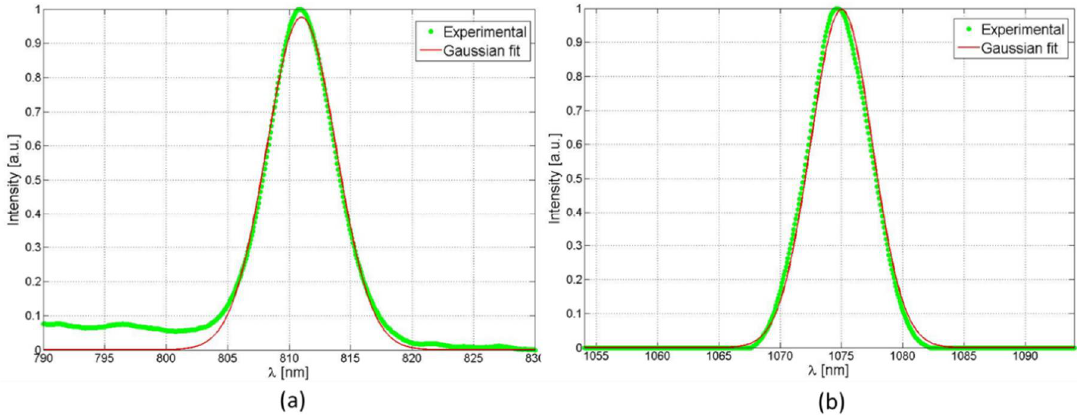
Figure 5. Optical spectra of the pulsed laser sources ( a ) Ti:Sa and ( b ) OPO, respectively. Results of the Gaussian fit are also reported.